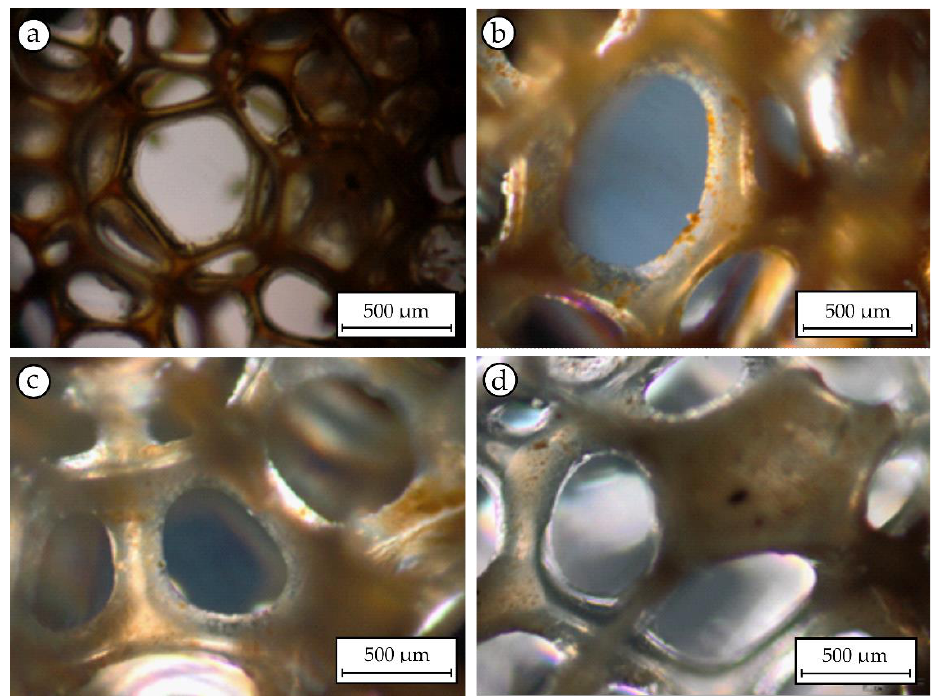
Figure 7. Microscopic images of the biofilm on the Linpor ® biofilm carriers, according to the sampling position and sampling time ( a ) upper layer (day 102), ( b ) upper layer (day 257), ( c ) middle layer (day 257), ( d ) lower layer (day 257).